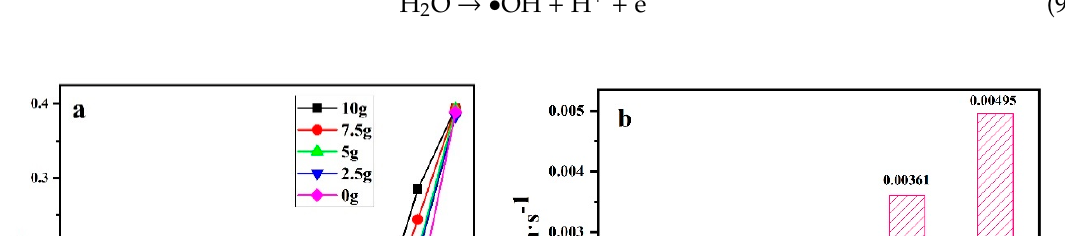
Figure 1. ( a ) Ampere–voltage of different particle dosage ( b ) the corresponding mass transfer coefficient.